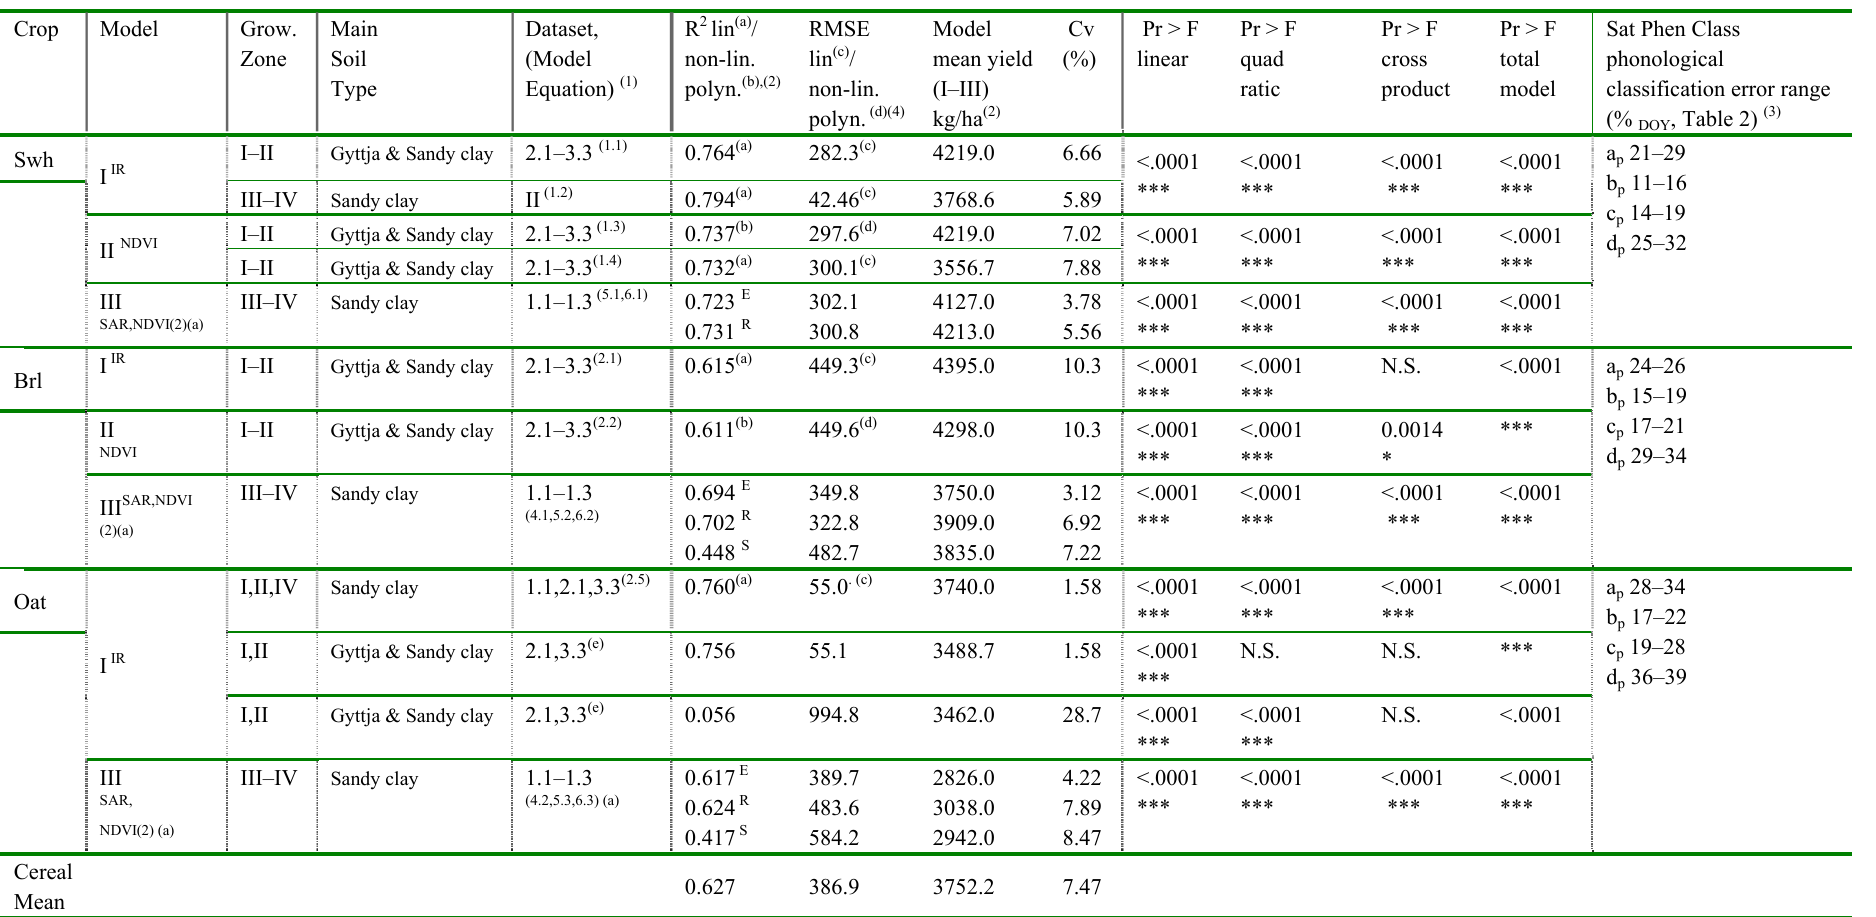
, kg/ha) for spring cereals [64,65]. b